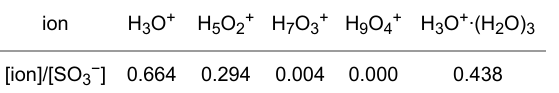
Table 1: Average relative content of different hydrated proton